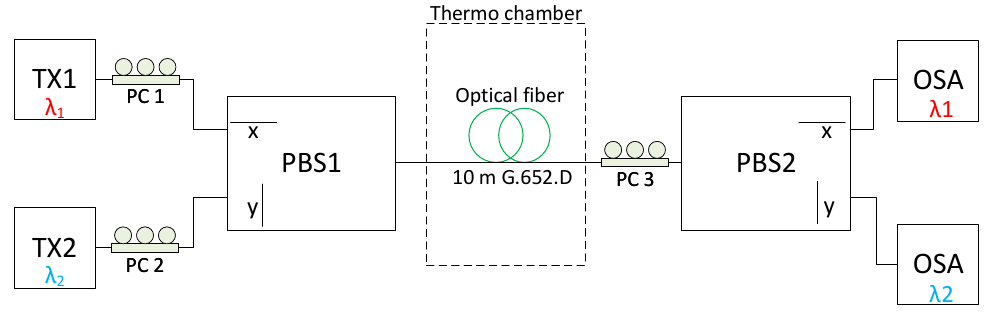
Figure 2. Block scheme of the measurement test